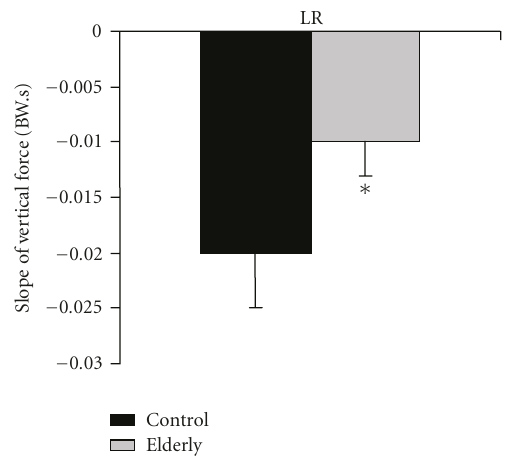
Figure 6: Slope of vertical force (LR) during stepping up. ∗ denotes being significantly di ff erent from control subjects ( P < . 05).